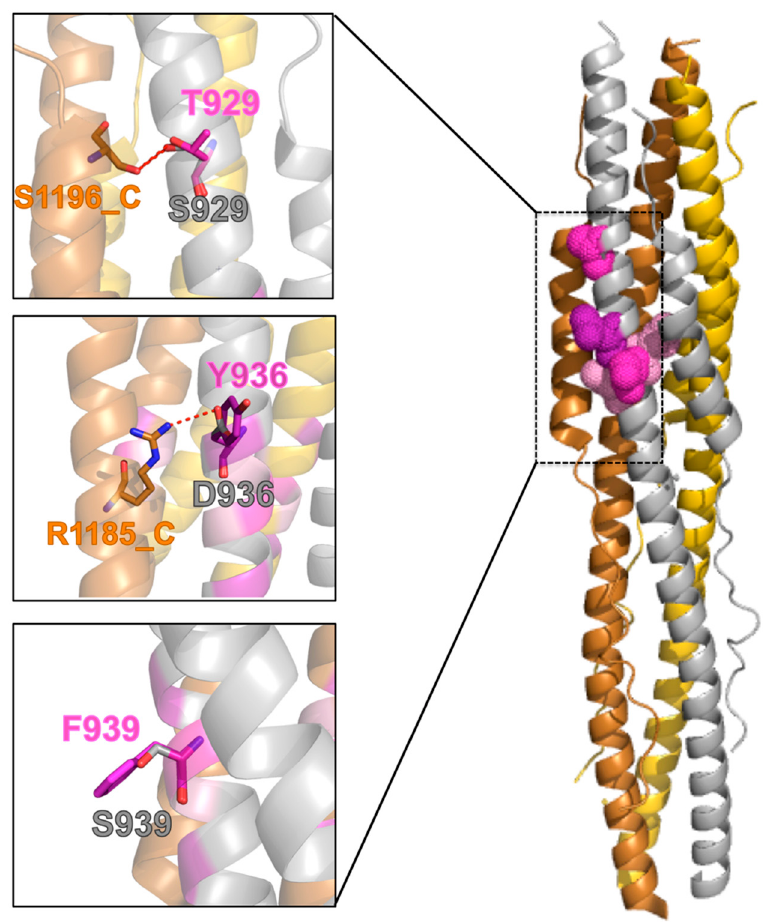
Figure 4. Mutants in the post-fusion conformation. Right: Cartoon representation of the SARS-CoV-2 S protein in its post-fusion trimeric conformation (the three monomers are colored in silver, gold, and copper, PDB ID: 6LXT). The color code is the same in Figure 3. Mutations in the HR1 fusion core are shown in a “dots” representation for chain A. Left: Focus on the structural context of each wild-type residue (silver sticks) and corresponding mutant (purple sticks). H-bonds are shown as red, dashed lines.